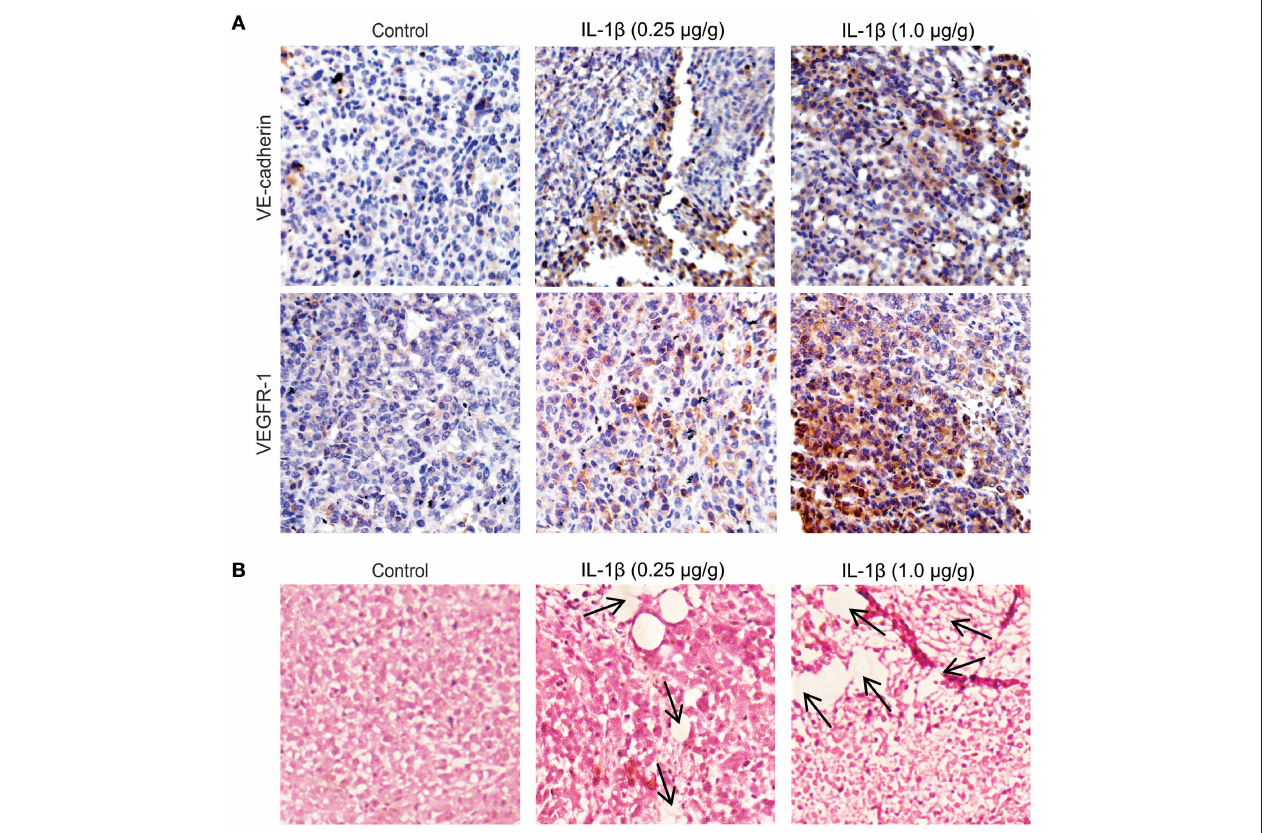
FIGURE 2 | VM biomarkers and microvessel formation increases in IL-1 β treated breast cancer tissues of mice models. (A) Immunohistochemical staining for the analysis of the expression of VE-cadherin and VEGFR-1 in the paraffine-embedded tumor slides (4 µ m) IL-1 β (0.25 and 1 µ g/g) treated xenografts and control. (B) Analysis of microvessel formation (indicated by arrows) by hematoxylin and eosin staining in control and in IL-1 β (0.25 and 1 µ g/g) treated tumor models (Magnification